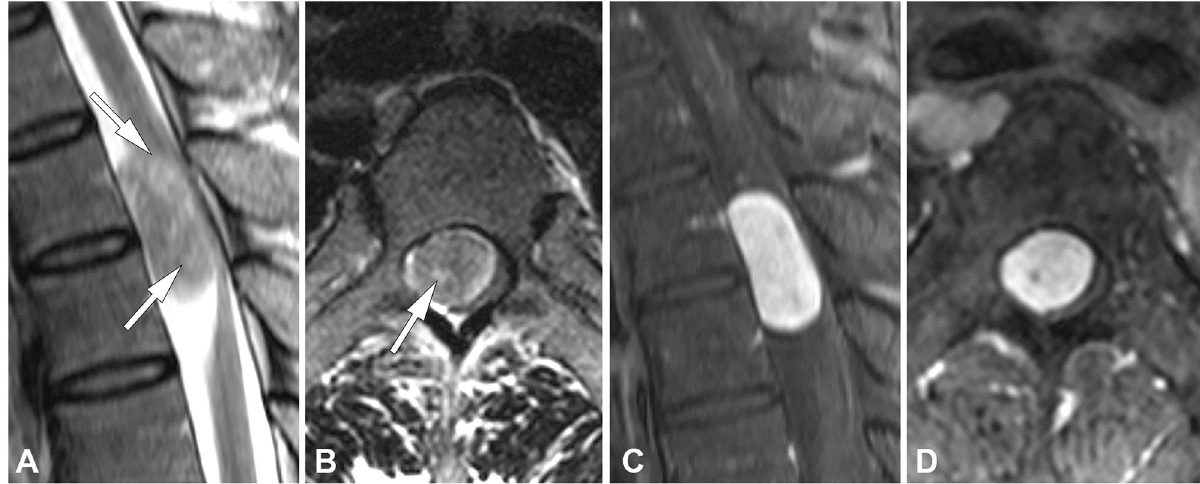
Fig 2. A schwannoma in a 42-year-old man. ( A ) Sagittal and ( B ) axial T2-weighted images show an intradural extramedullary mass on the T4-5 level with immeasurably small foci of fluid signal within the tumor (arrows), which was considered to represent cystic change. ( C ) Sagittal and ( D ) axial fat- suppressed contrast-enhanced T1-weighted images show relatively homogeneous